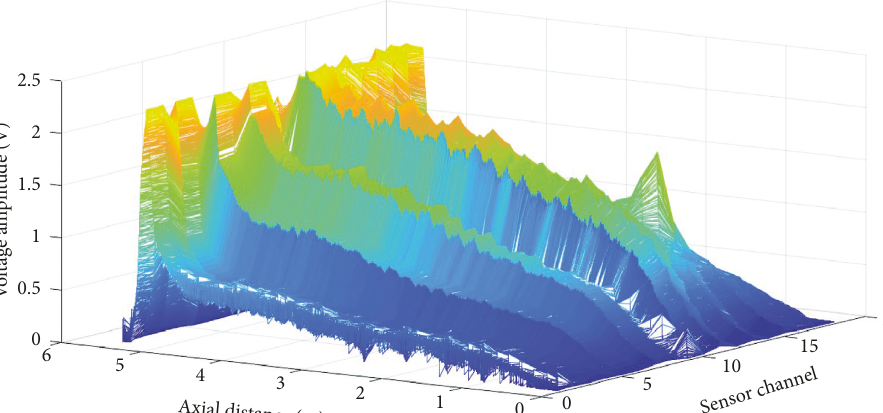
Figure 2: Raw data of MFL signal.